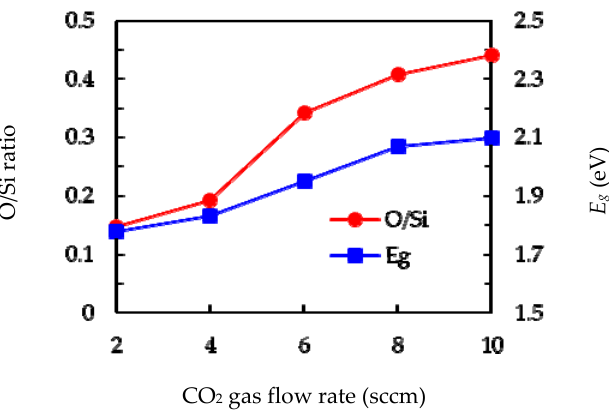
Figure 2. Atomic ratio of O/Si and band gap of the films deposited with different CO 2 flow rate. Standard cubic centimeters per minute (sccm).